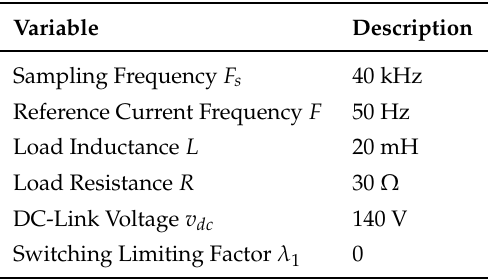
Figure 7. Zedboard evaluation module ( a ) for Zynq 7000 SoC with custom daughter board for sensors Table 2. System variables and